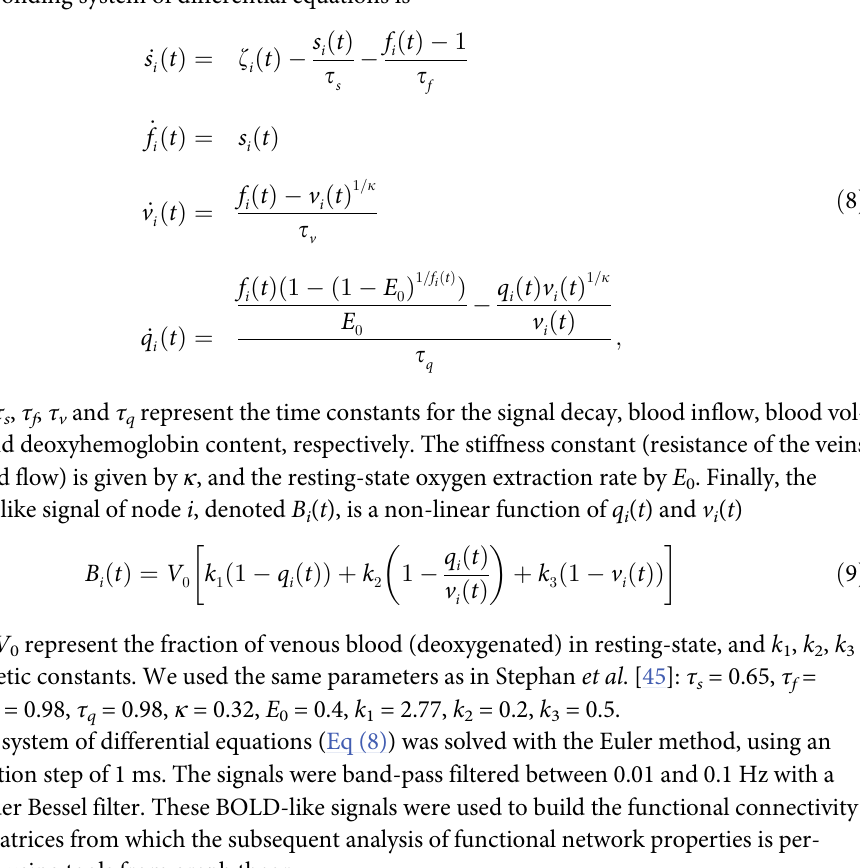
ffiffiffiffiffiffiffi p (cid:0) 1 the imaginary unit, |•|